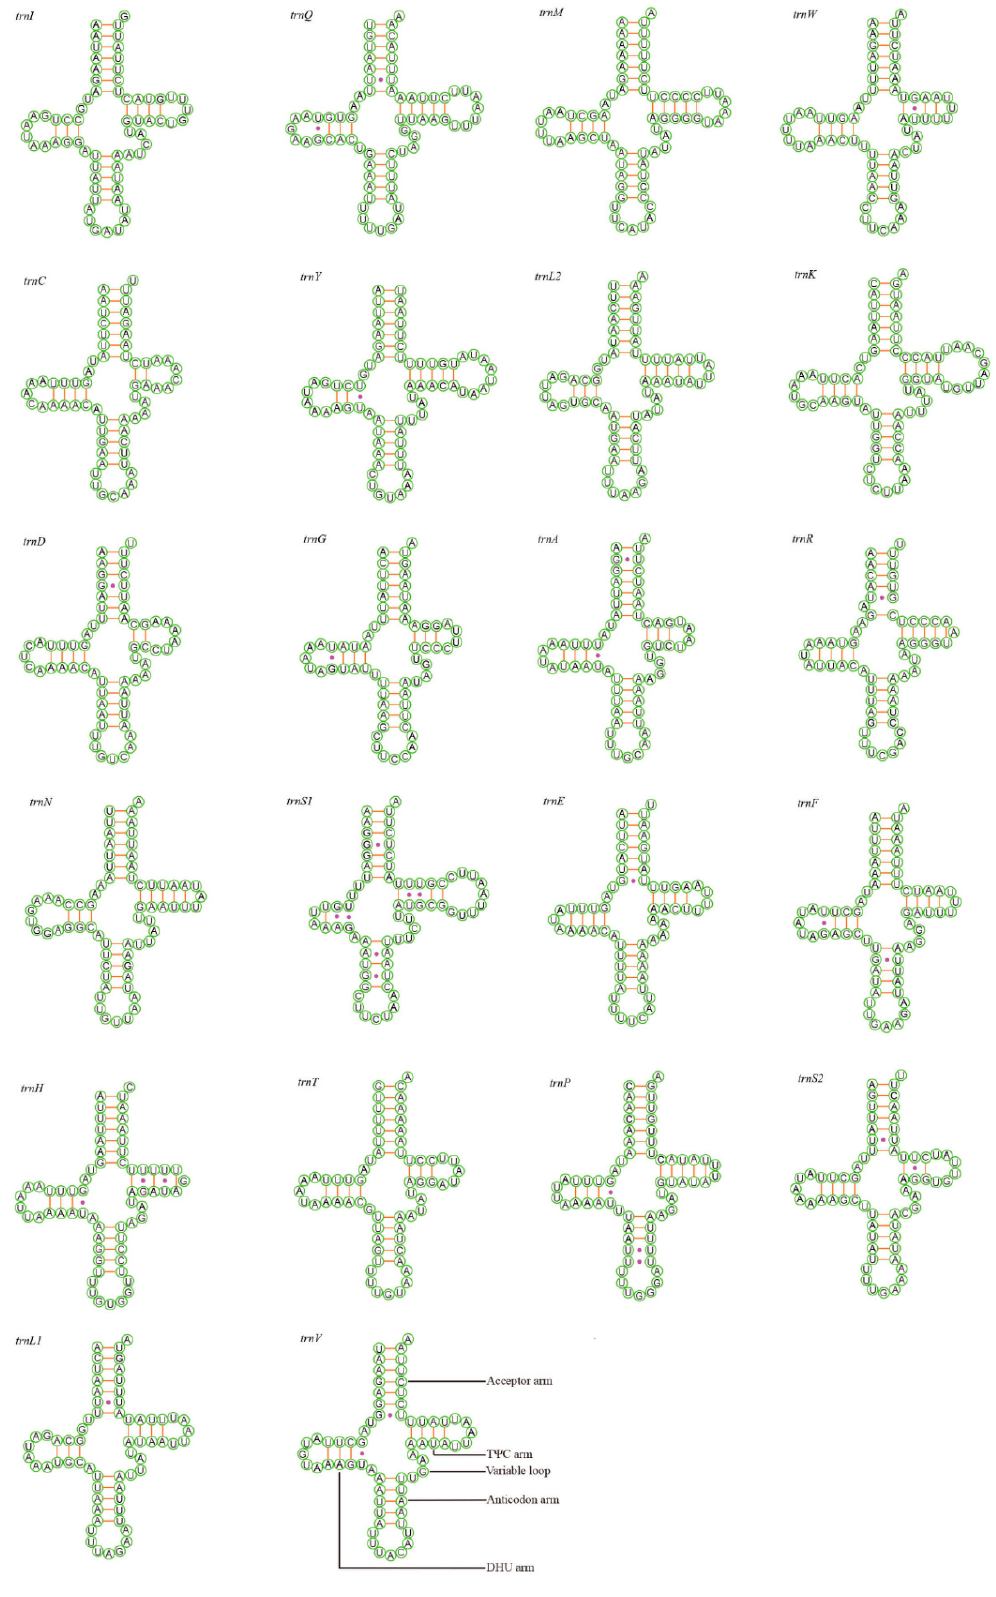
Figure 3. Predicted secondary cloverleaf structure for the tRNAs of Alebroides salicis .